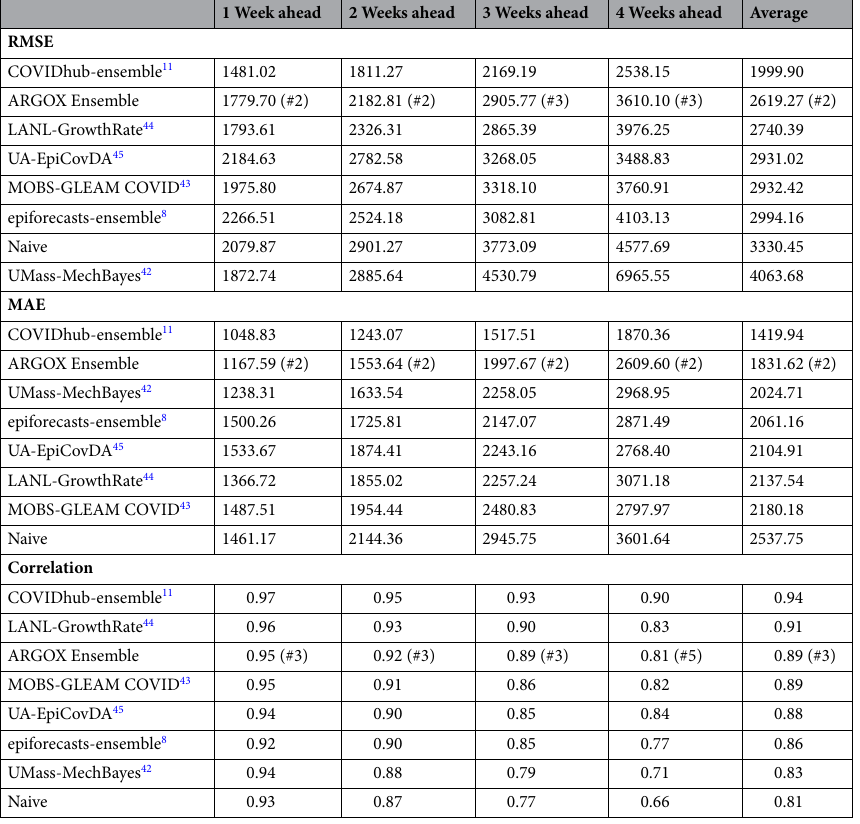
Table 4. Comparison among different models’ 1 to 4 weeks ahead U.S. national level weekly incremental death predictions (from 2020-07-04 to 2022-03-05). The RMSE, MAE, Pearson correlation and their averages are reported. Methods are sorted based on their average. Our ARGOX-Ensemble’s rankings for each error metric are included in